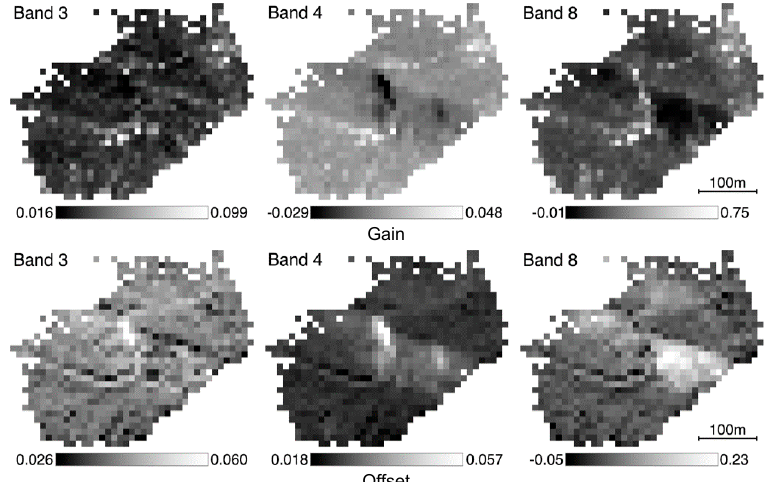
Figure 10. Gain ( top ) and offset ( bottom ) of the pixel-based linear regression of reflectance against the sunlit fraction.